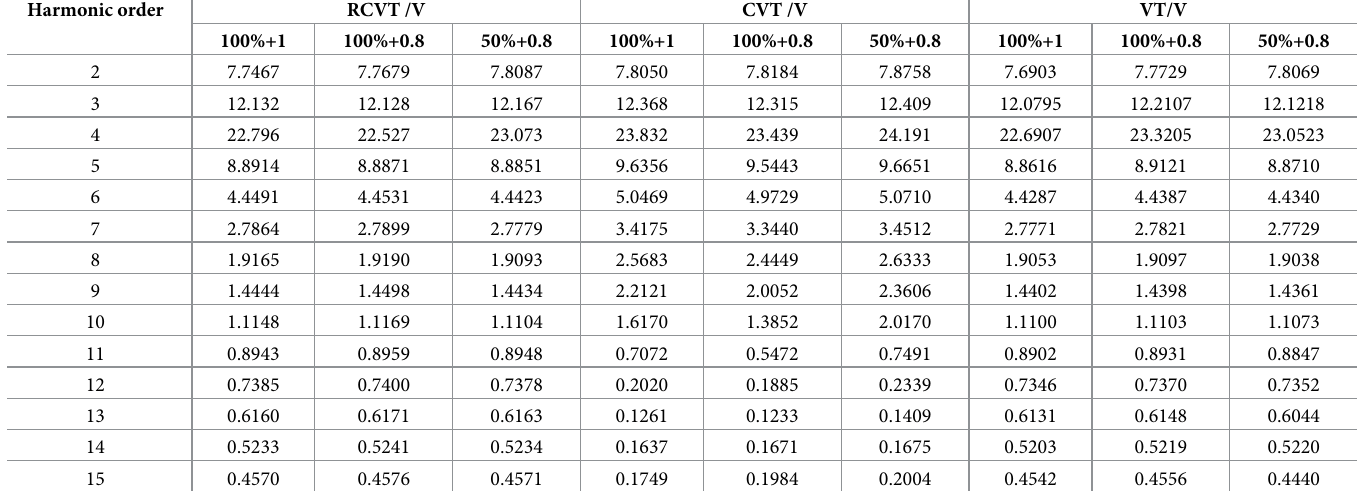
Table 8. RMS values of the measured harmonic voltages.